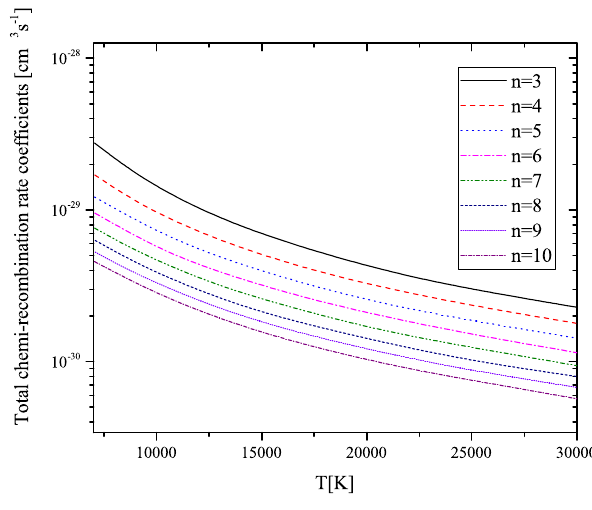
Figure 7. Same as in Figure 6, but for the inverse process (i.e.,